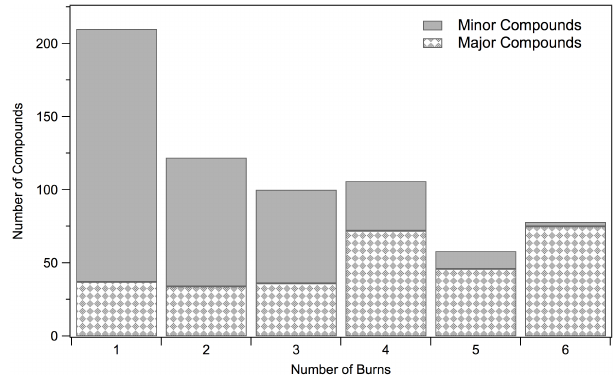
Figure 8. Histogram of the number of compounds present in the indicated number of burns. Compounds were considered major if the EF was >0.01 gkg − 1 in any burn. All other compounds were classified as